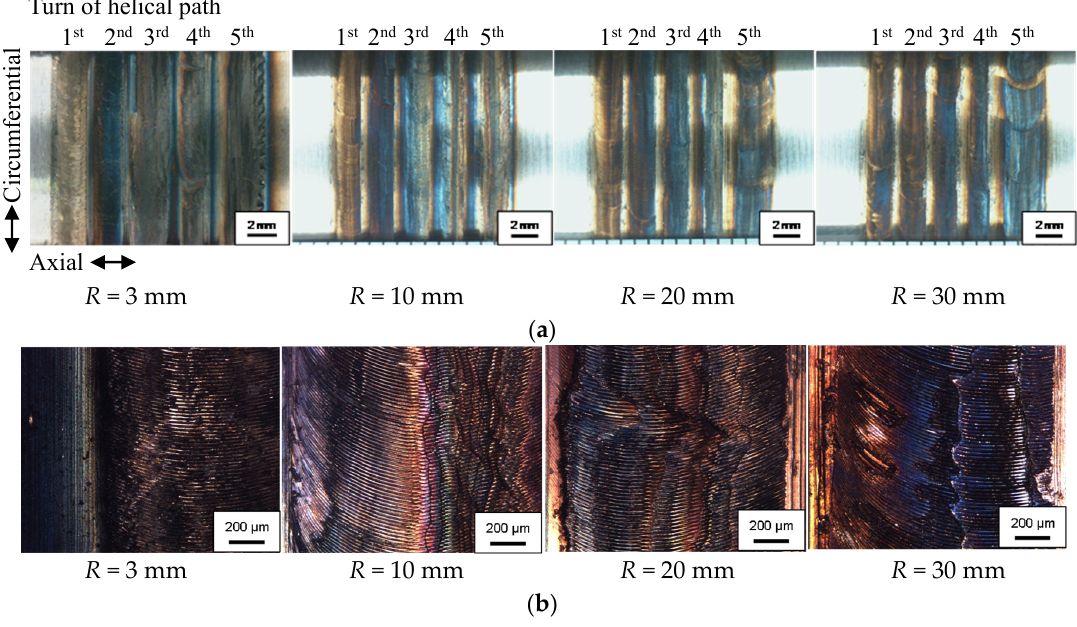
Figure 10. Processed surfaces: ( a ) Overall view; and ( b ) Enlarged view.